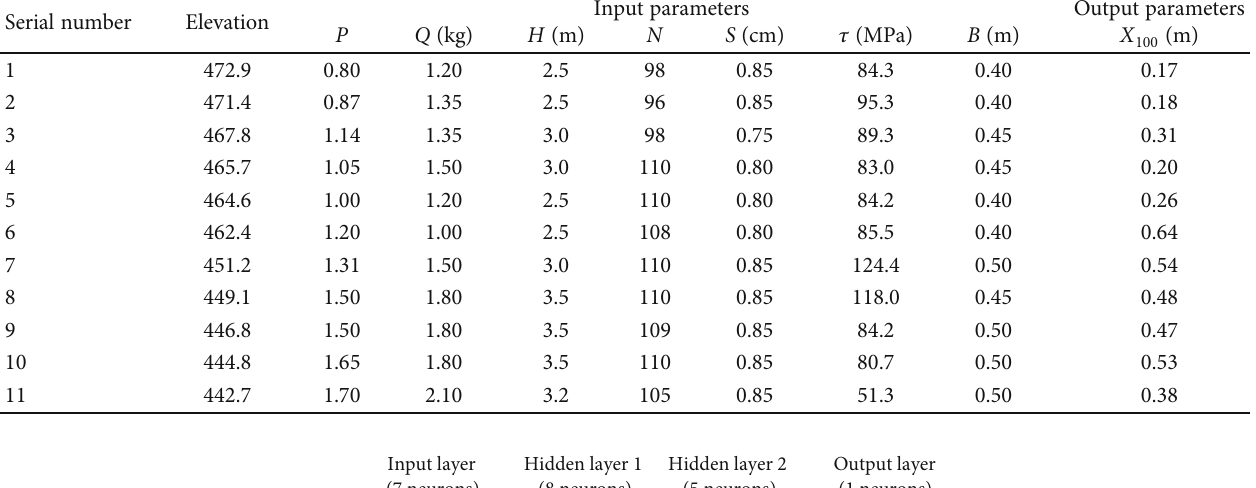
Table 4: Training parameters of blasting maximum fragmentation